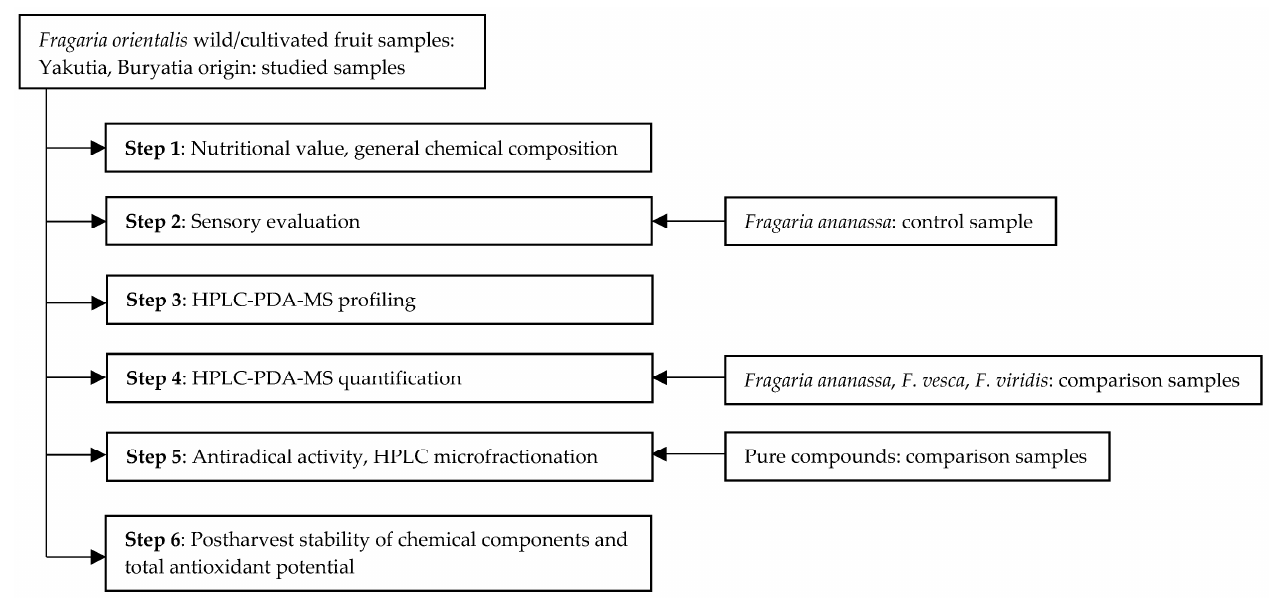
Figure 2. Flow chart for the experimental work with F. orientalis fruits.